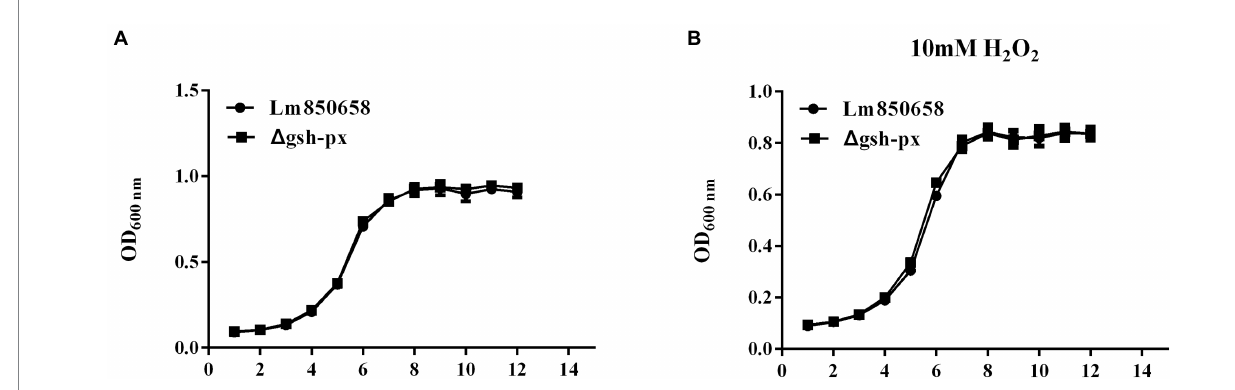
FIGURE 1 Deletion of gsh-px did no effect on the growth of L. monocytogenes in vitro . Overnight-grown bacteria were washed and diluted (1:100) in fresh BHI broth with (B) or without H 2 O 2 (A) , incubated at 37 ° C for 12 h. Data were expressed as mean ± SD.